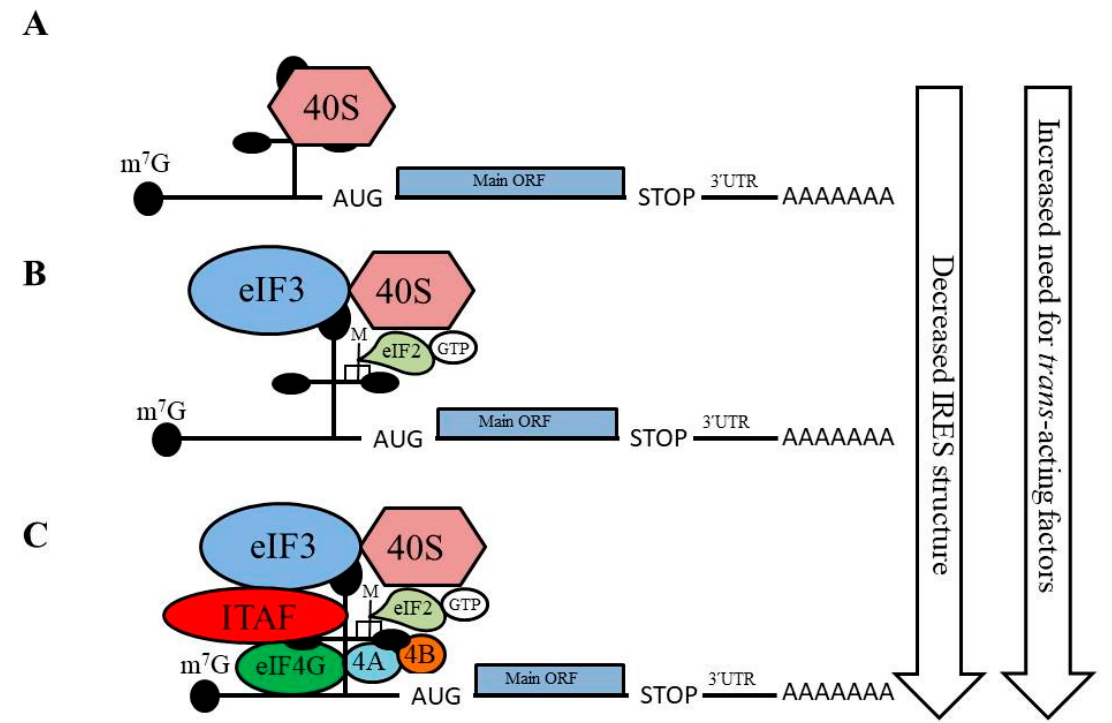
Figure 1. Overview of internal ribosome entry site (IRES)-mediated translation initiation. The requirement for canonical initiation factors and IRES trans-acting factors (ITAFs) varies among IRES-containing mRNAs. Several types of IRES-mediated translation initiation have been identified: ( A ) Group I: no canonical factors are required and the 40S ribosome is directly recruited to the mRNA by the IRES structure; ( B ) Group II: a few canonical initiation factors are required for 40S ribosome recruitment; ( C ) Groups III and IV: multiple canonical initiation factors, as well as ITAFs, are required for 40S ribosome recruitment and translation initiation.